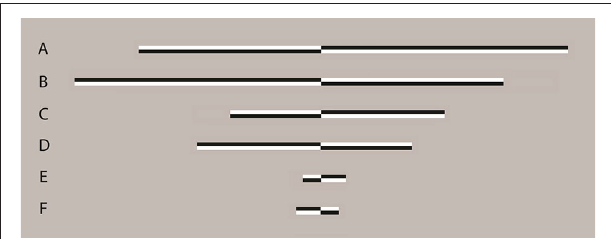
FIGURE 1 | Examples of line stimuli used in the experiment . Lines were transected at 1 of 13 locations ranging symmetrically from ± 7.5% (distance between transector locations = 1.25%) of absolute line length relative to and including veridical center. In long lines, this represented a range of − 1.48 ◦ to 1.48 ◦ of visual angle (VA) with a distance between transector locations of 0.25 ◦ of VA. In medium lines a range of − 0.74 ◦ to 0.74 ◦ of VA with a distance between transector locations of 0.12 ◦ of VA was presented and in short lines, a range of − 0.15 ◦ to 0.15 ◦ of VA with a distance between transector locations of 0.02 ◦ of VA was presented. All lines were displayed with the transector location centered on the vertical midline of the display (i.e., aligned to a central fixation cross which preceded the presentation of the lines). Lines A, C and E are transected to the left of veridical center whereas lines B, D and F are transected to the right of veridical center. Lines of varying contrast polarity appeared with equal frequency and the order of appearance was